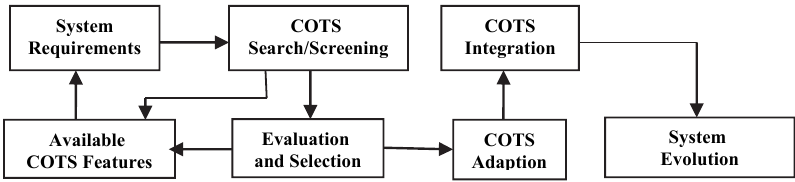
Fig. 1. COTS-based software development